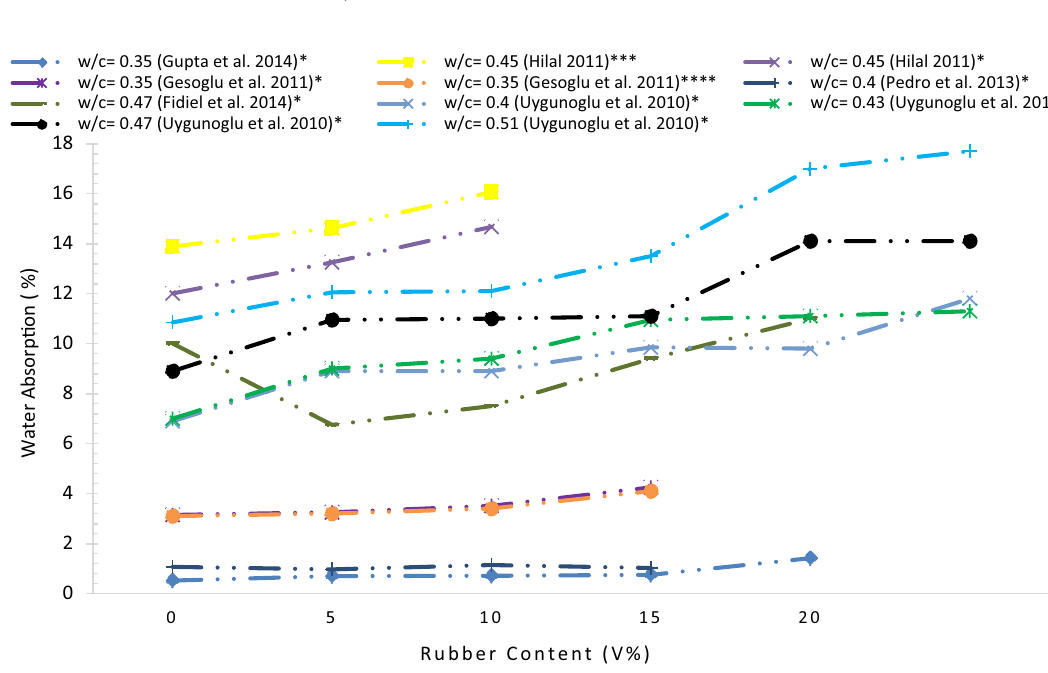
Fig. 15 MOE of crumb rubber concrete at 28 days [31, 67, 114]